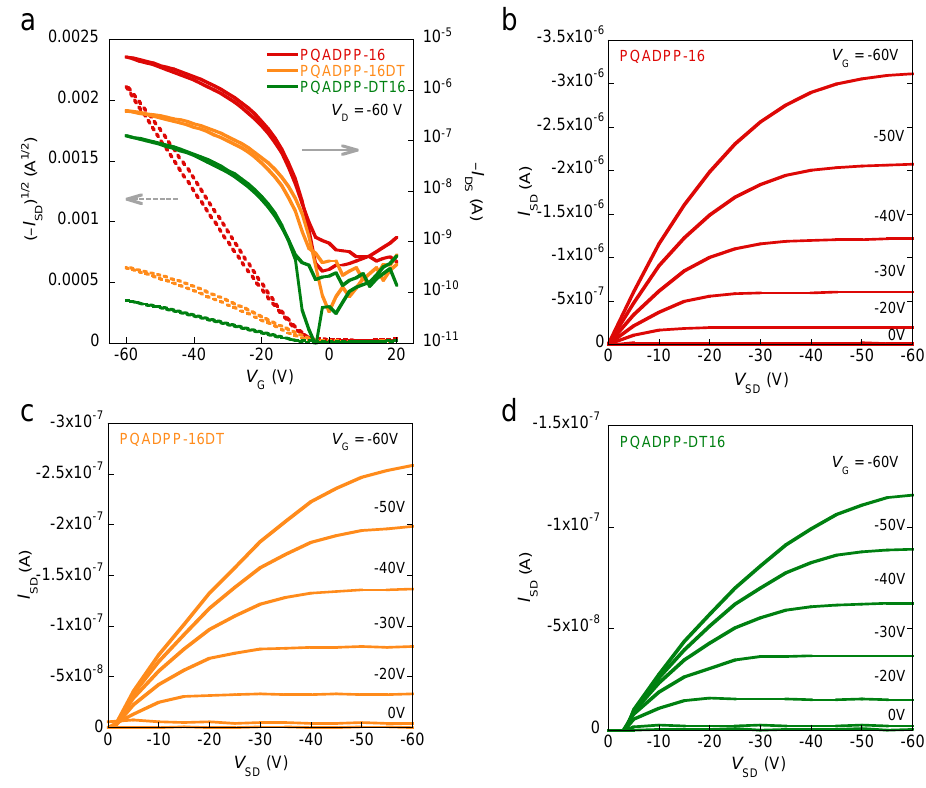
Figure 4. Transfer characteristics of OFETs based on PQADPP-16, -16DT, and -DT16 ( a ) and output characteristics of OFETs based on PQADPP-16 ( b ); -16DT ( c ); and -DT16 ( d ).